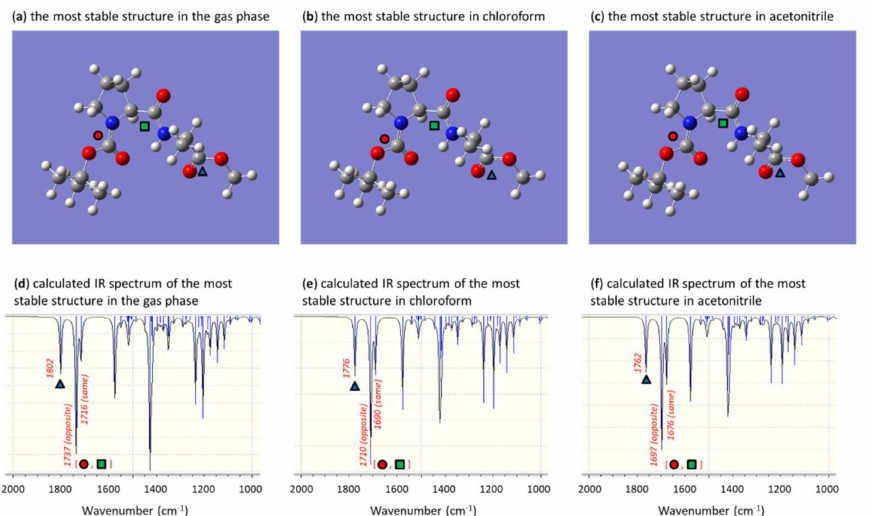
Figure 15. The most stable structure and calculated IR spectra of N -Boc-L-proline-L-alanine-OMe 6 : ( a ) The most stable structure in the gas phase; ( b ) the most stable structure in chloroform; ( c ) the most stable structure in acetonitrile; ( d ) calculated IR spectrum in the gas phase; ( e ) calculated IR spectrum in chloroform; ( f ) calculated IR spectrum in acetonitrile. Same and Opposite in ( d , f ) mean the stretching vibration in the same direction and opposite direction for each carbonyl bond,